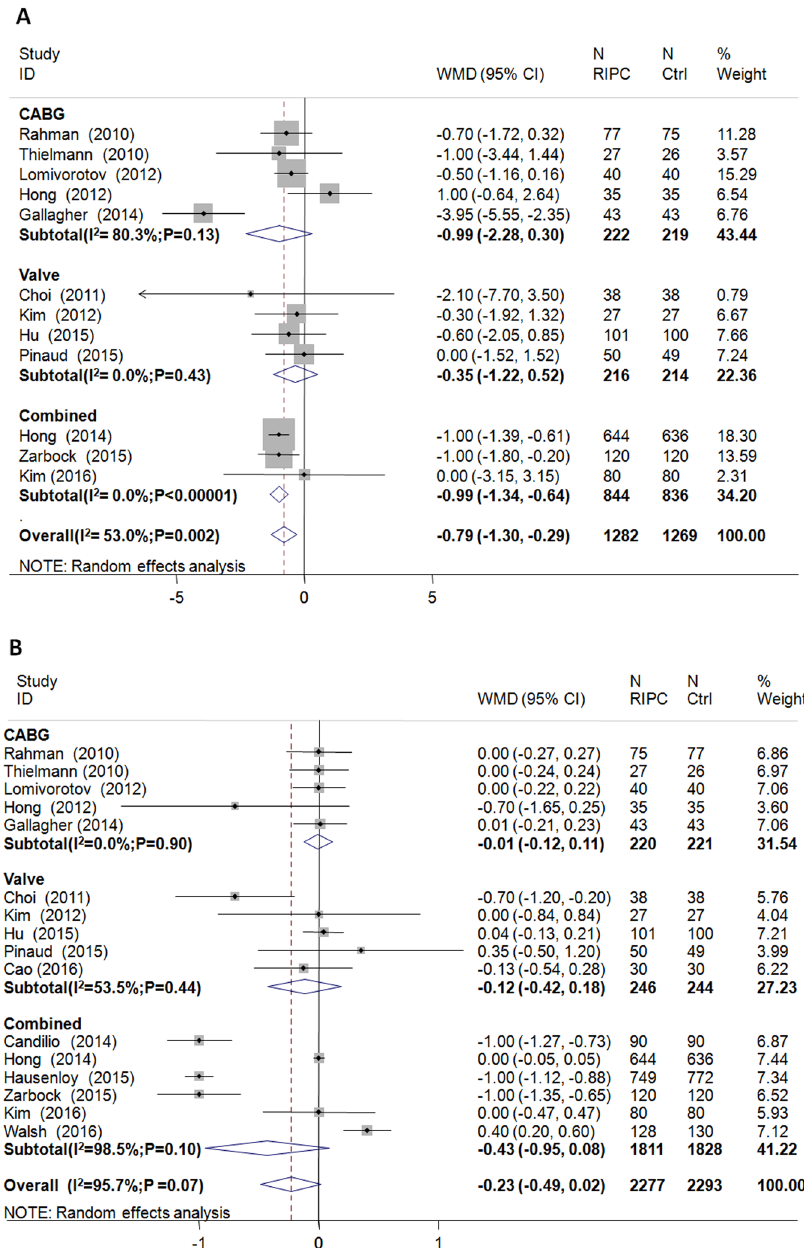
Figure 3. Forest plot of the effect on RIPC on ( A ) MV duration and ( B ) hospital length of